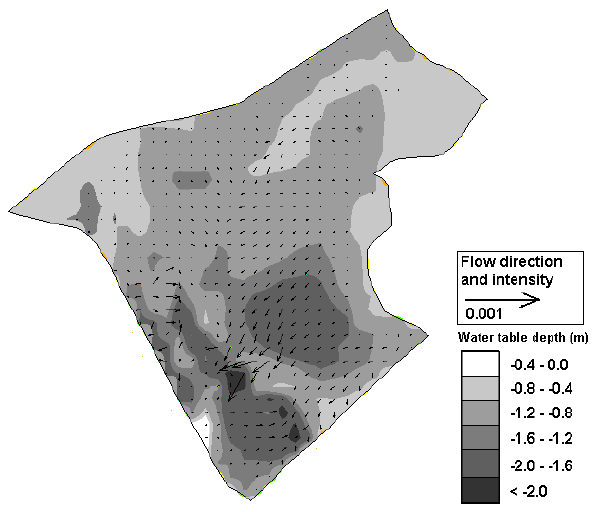
Fig. 8b. Spatial distribution of water table depth and flow direction in the duration of low precipitation.